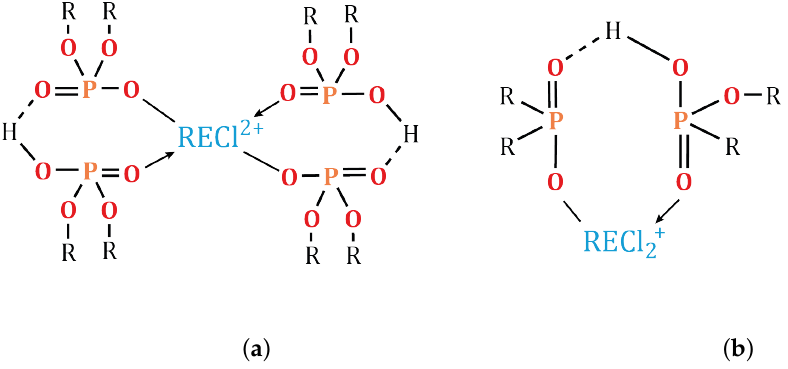
Figure 18. Structure of the extracted species. REH 2 ClA 4 ( a ) and REHClBC ( b